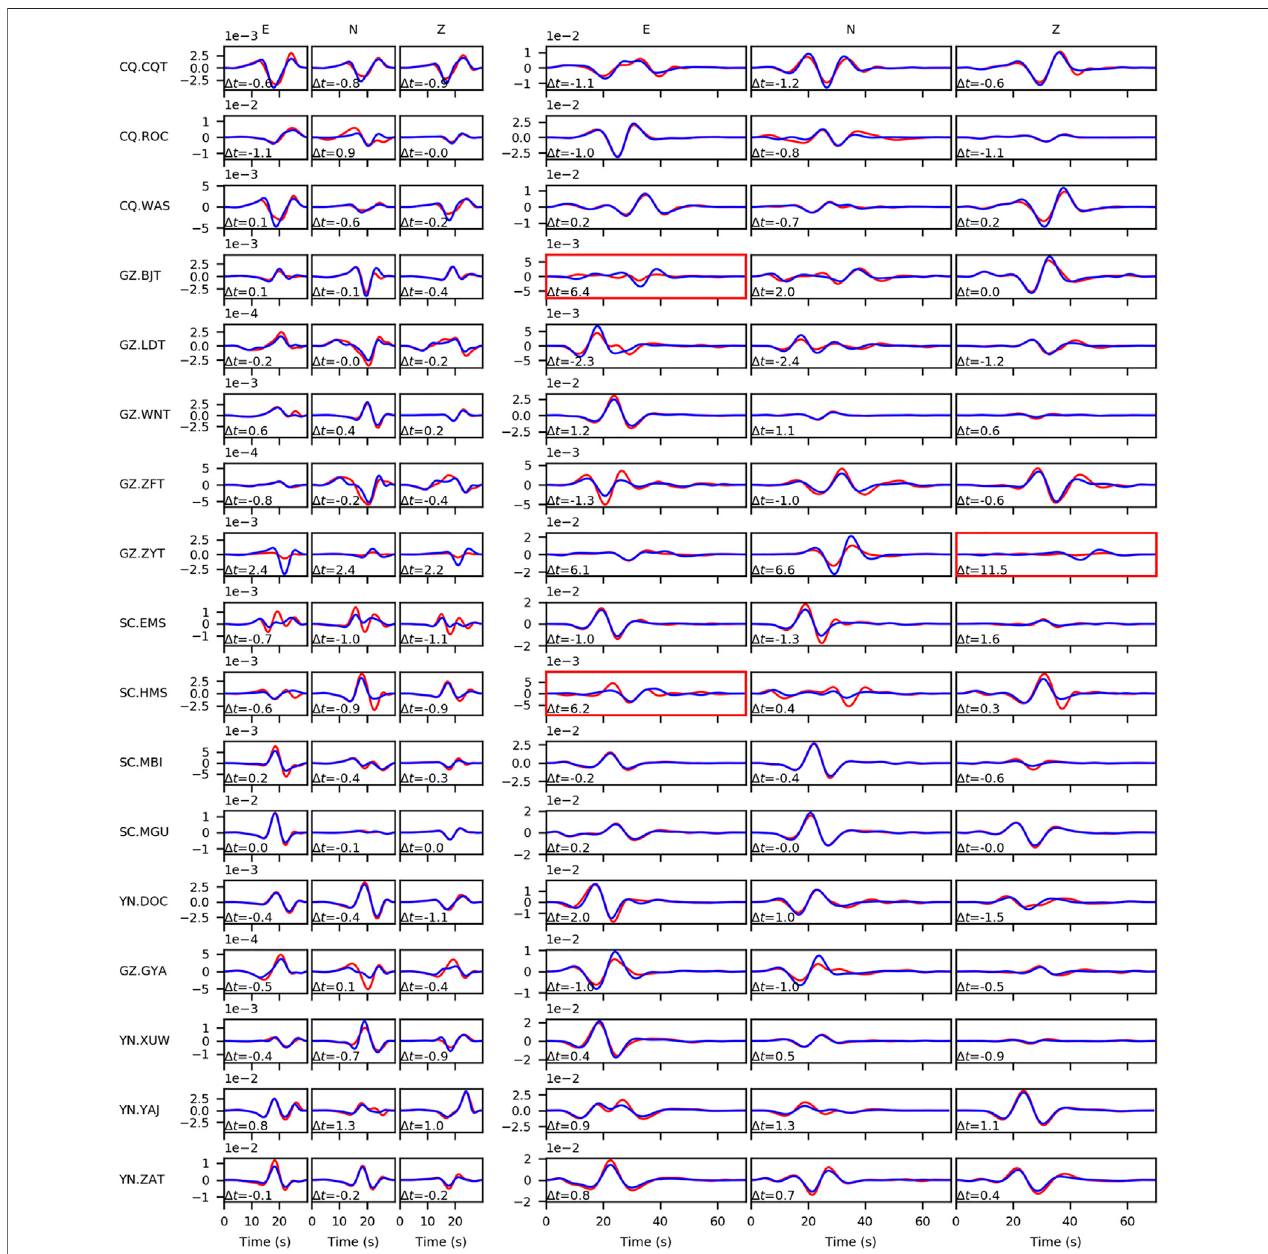
FIGURE10| Thewaveform fi ttingofthethree-component(ENZ)Pwave(leftthreecolumns,0.04 – 0.2 Hz)andthesurfacewave(rightthreecolumns, 0.03 – 0.1 Hz) at all stations utilized for inversion. The leftmost texts in each row mark the seismic network and station names. The red and blue solid lines indicate the observation and thesyntheticdatausingtheoptimumsourcepositionandmechanismrespectivelyalongwiththetimeshiftbeloweachwaveform.Theredrectanglesmarkthesegments in which the time shifts are not used in the calculation of traveltime residuals.